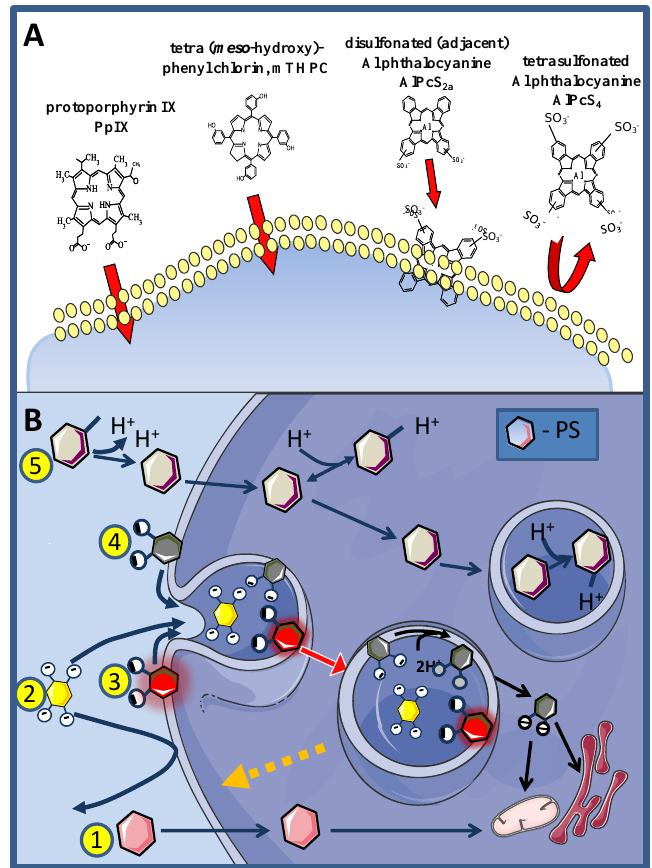
Figure 2. Pathways for cellular uptake of PSs. Photosensitizer penetration through a cellular membrane is influenced by its physico-chemical properties. ( A ) PSs with a low number of charged side groups, such as PpIX and mTHPC, that may be protonated at physiological pH (down to approx. pH 5 in lysosomes) are able to penetrate cellular membranes by passive diffusion while strongly amphphilic (e.g., AlPcS 2a ) and hydrophilic PSs (AlPcS 4 ) will instead be taken up into cells through endocytosis. ( B ) Describes the various routes for cellular uptake of PSs. For numbering and description of the routes see the text.